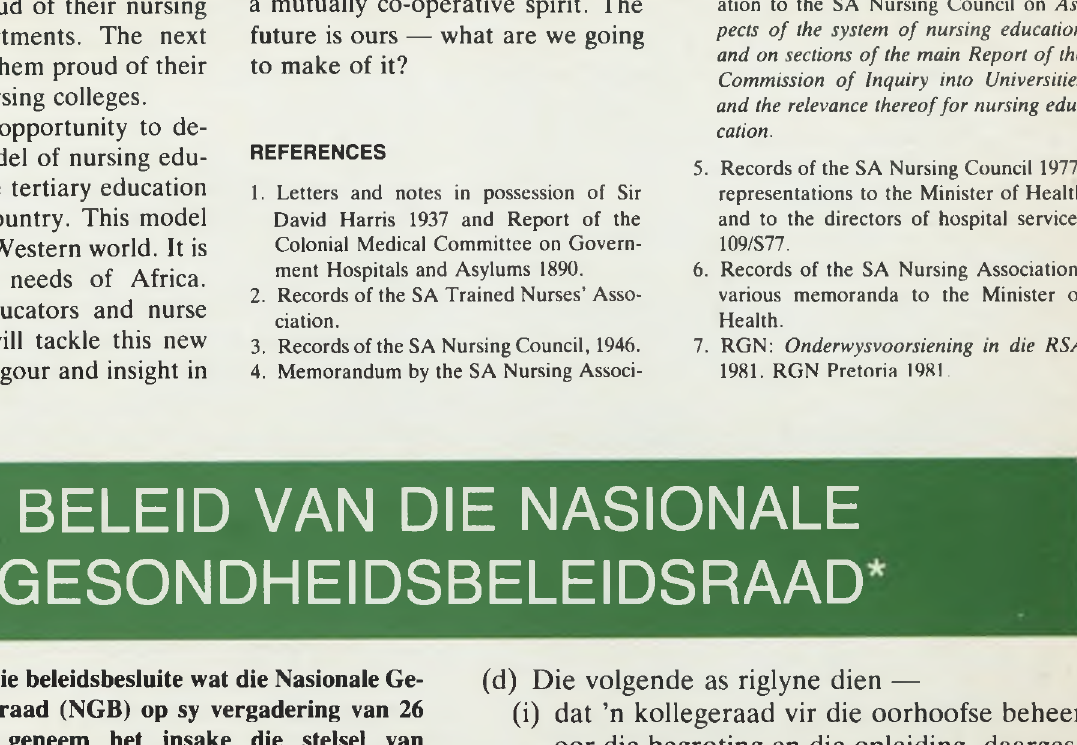
BELEID VAN DIE NASIONALE GESONDHEIDSBELEIDSRAAD